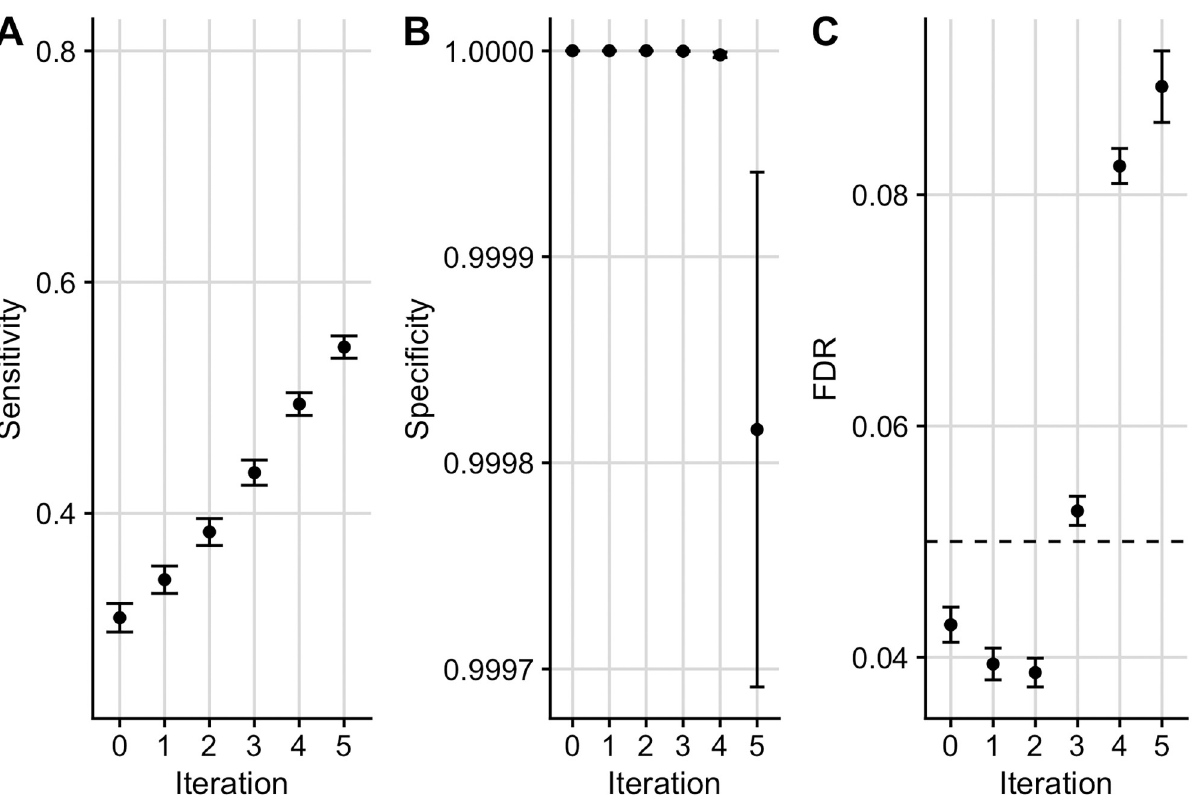
Fig 2. Simulation results for scenario E. Mean +/- standard error for the sensitivity (A), specificity (B) and FDR (C) of FDR values from Flexible cFDR when iterating over auxiliary data sampled from the same distribution (“simulation E”). Iteration 0 corresponds to the original FDR values. Our sensitivity proxy is calculated as the proportion of SNPs with r 2 � 0.8 with a causal variant (“truly associated”), that were detected with a FDR value less than 5 × 10 − 6 . Our specificity proxy is calculated as the proportion of SNPs with r 2 � 0.01 with all the causal variants (“truly not-associated”), that were not detected with a FDR value less than 5 × 10 − 6 . Our FDR proxy is calculated as the proportion of SNPs that were detected with a FDR value less than 0.05, that had r 2 � 0.01 with all the causal variants (“truly not-associated”) (we raised α to 0.05 in order to assess FDR control within a manageable number of simulations). Results were averaged across 100